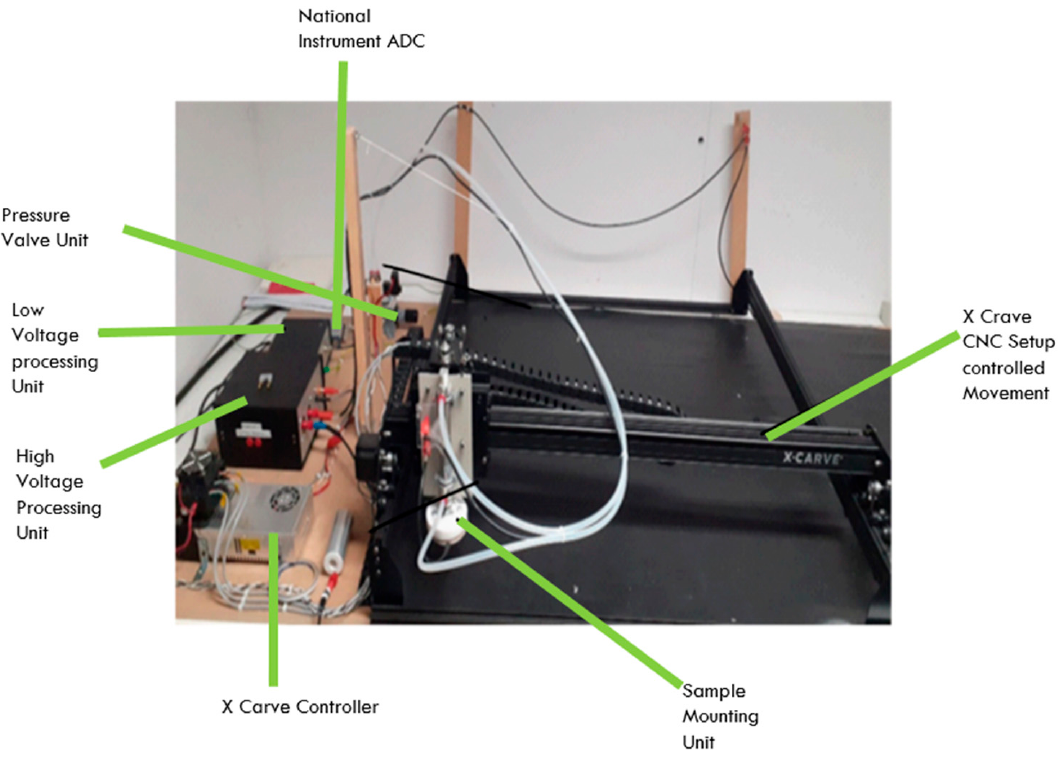
Figure 1. Different components of electrostatic characterization device.